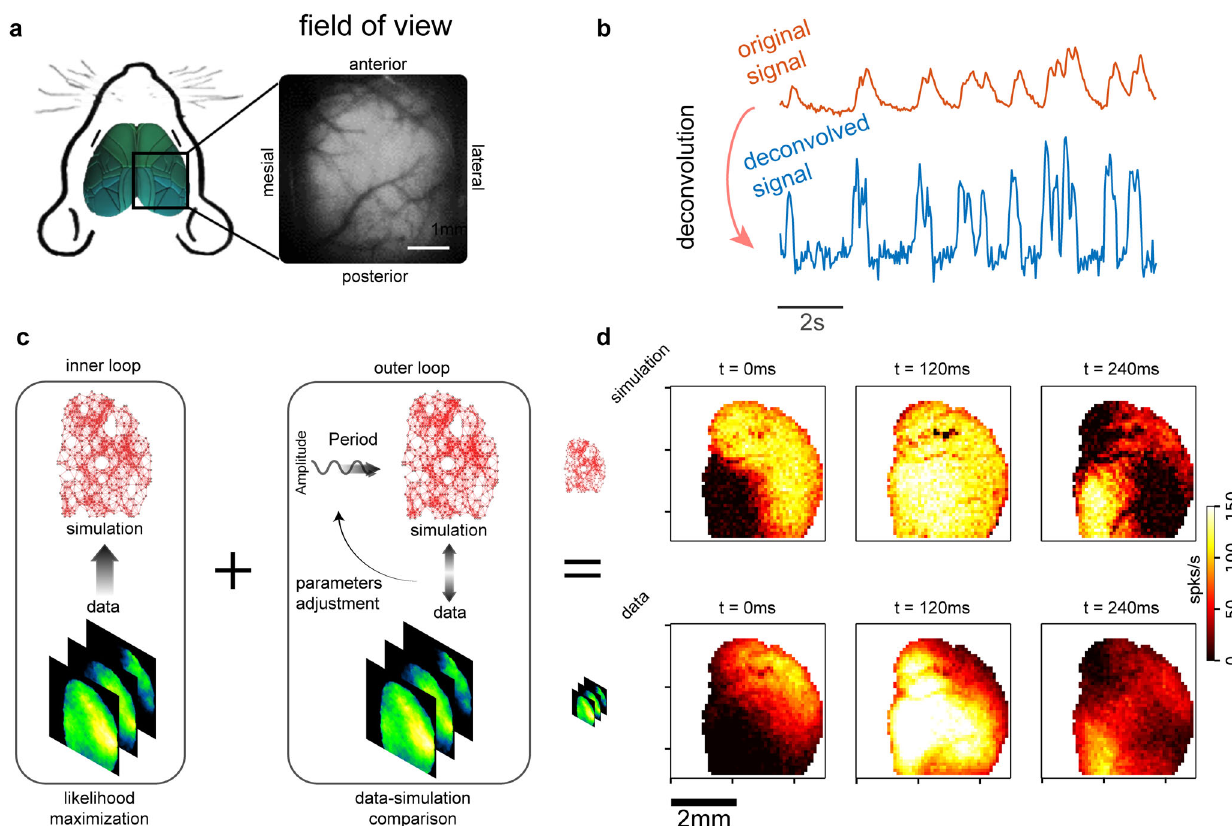
Fig. 1 Experimental setup and sketch of the model. a The cortical activity of the right hemisphere of a mouse (under Ketamine/Xylazine anesthesia) is recorded through wide- fi eld calcium imaging (GCaMP6f indicator). b The calcium indicator response is slow if compared with the time scales of neuron activity. Applying to the original signal (upper) a proper deconvolution function fi tted from single-spike response 7,79 , it is possible to estimate a good proxy for the average activity of the local population of excitatory neurons recorded by a single pixel (bottom). c Sketch of the inference model, made up of an inner loop (likelihood maximization) and an outer loop (search for optimal neuro-modulation-related hyper-parameters granting the best match between simulations and data). d Three frames from simulation (top) and experimental data (bottom), both expressing slow wave